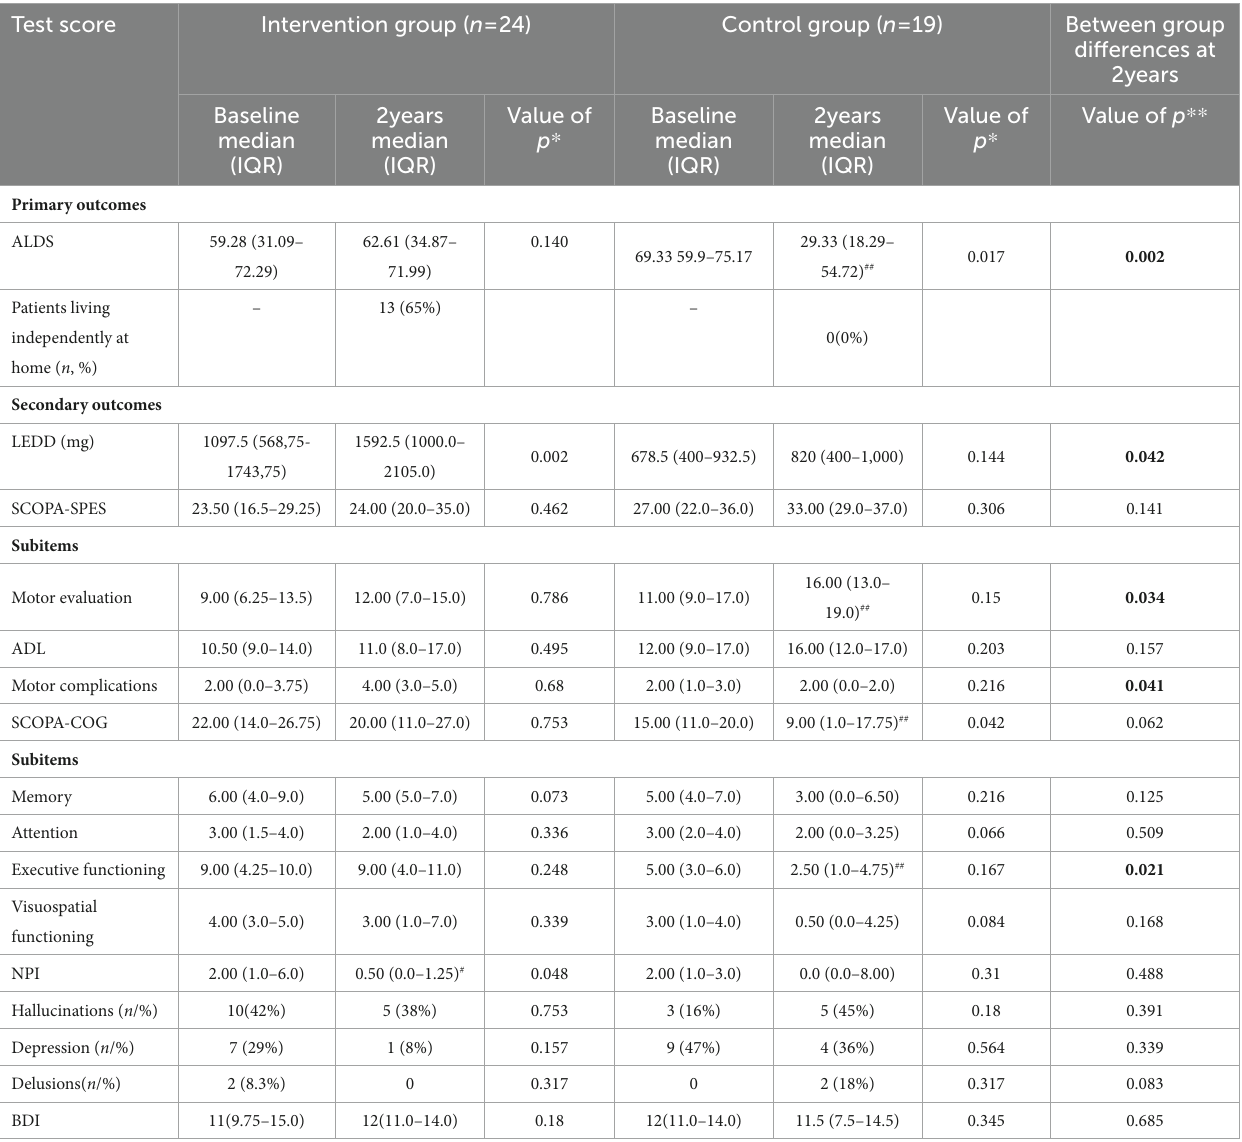
TABLE 2 Primary and secondary endpoints of patients in the rehabilitation-and control